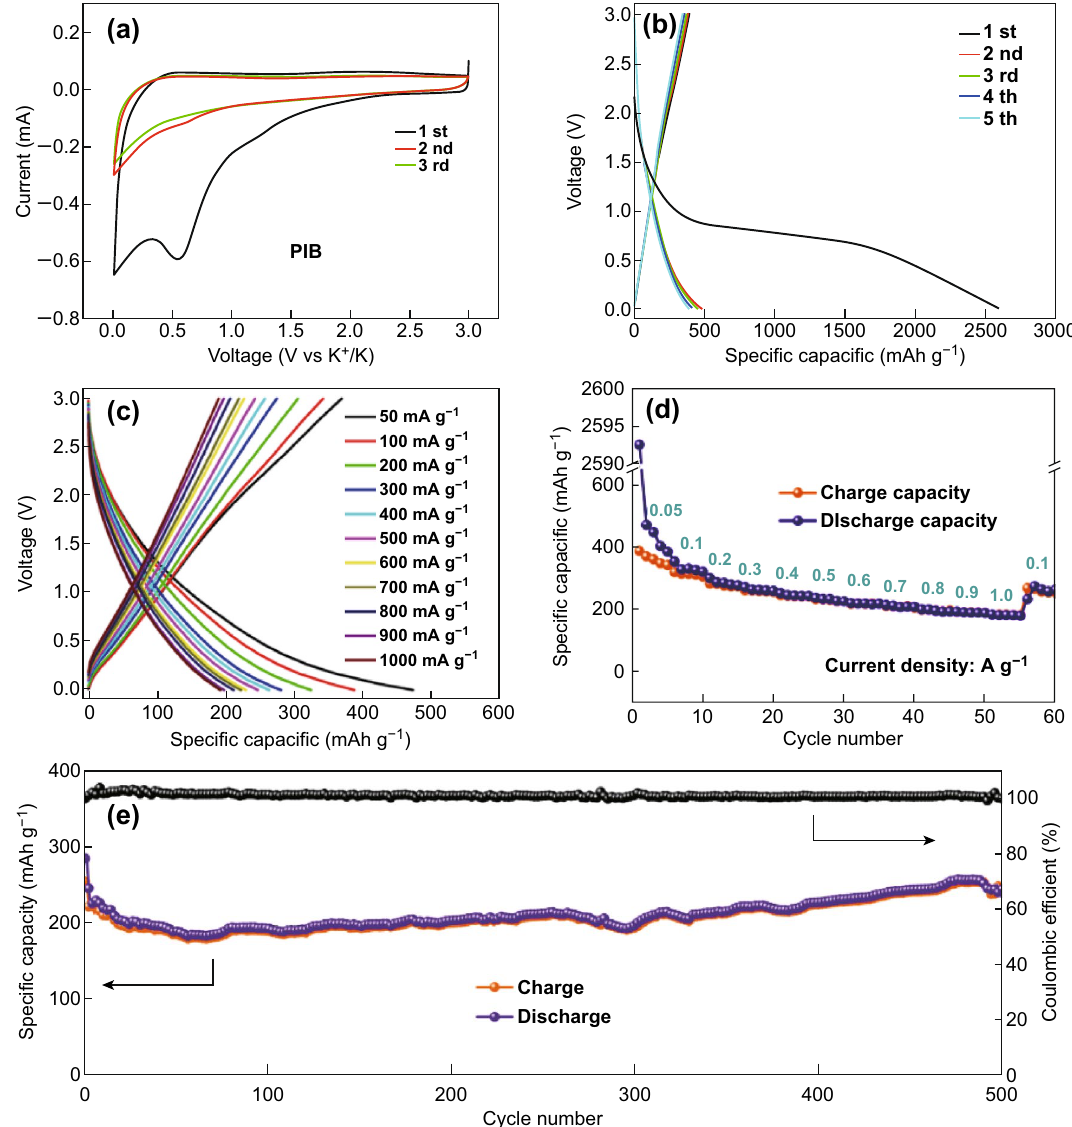
Fig. 5 a CV curves of NPG at a scanning rate of 0.2 mV s −1 . b Charge–discharge voltage profiles at a current density of 50 mA g −1 . c Typical galvanostatic lithiation/delithiation curves and d rate capabilities of NPG electrode at different current densities. e Cycling stability and coulom- bic efficiency of NPG electrode at a current density of 500 mA g